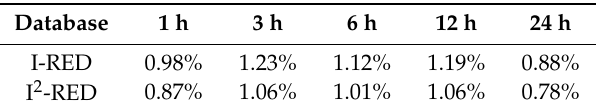
Table 1. Missing transcription in I-RED and I 2 -RED for the di ff erent durations. The percentages were evaluated by comparing the total number of records related to each duration (i.e., 105,940 for I-RED and 122,217 for I 2